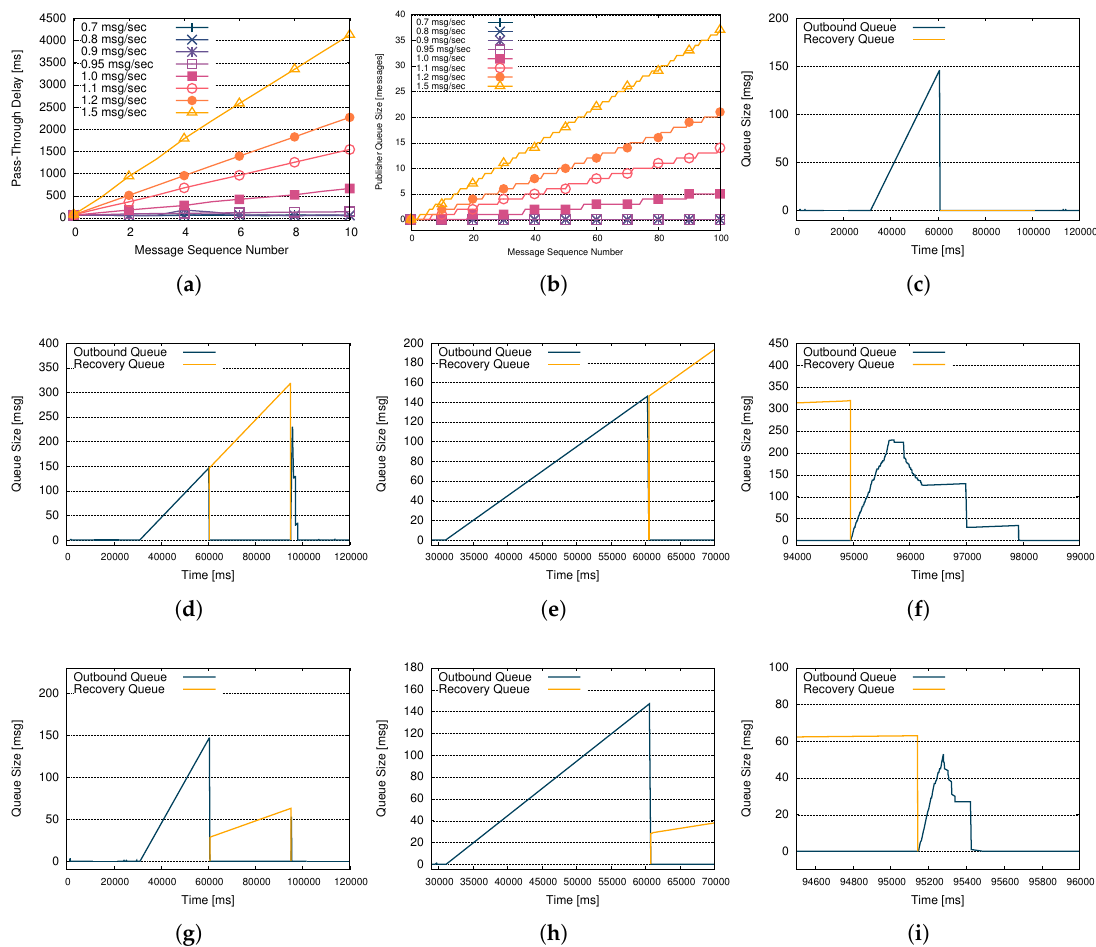
Figure 10. ( a ) State messages pass-through delays; ( b ) publisher queue sizes; ( c ) queue sizes adopting the NoRecovery Policy; ( d ) queue sizes adopting the AllRecovery Policy; ( e ) queue sizes adopting the AllRecovery policy during the disconnection event; ( f ) queue sizes adopting the AllRecovery policy during the reconnection event; ( g ) Queue sizes adopting the OneEveryNRecovery policy; ( h ) queue sizes adopting the OneEveryNRecovery policy during the disconnection event; ( i ) queue sizes adopting the AllRecovery policy during the reconnection